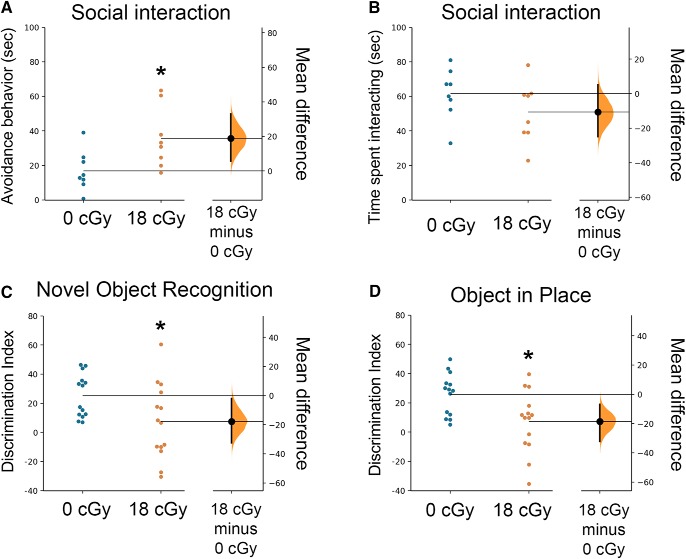
Space-relevant, low dose-rate neutron irradiation disrupts cognition. A, B, Social interaction behavior testing of mice 3 months after the conclusion of neutron irradiation (18 cGy cumulative dose) reveals an increase in avoidance behavior during 10 min trials compared with un-irradiated control mice, whereas the total time spent interacting did not change. C, Disrupted performance on a NOR task by irradiated mice indicates a significant decrement in novelty recognition memory. D, The spatial exploration behavior analyzed for the OiP task demonstrates that neutron irradiation impairs spatial memory retention as manifested in a reduced preference to explore the novel placement of objects. Data are presented as mean ± SEM (A, N = 8 per group; B–D, N = 14 per group). *p < 0.05 (Mann–Whitney’s two-tailed, nonparametric t test) compared with controls.